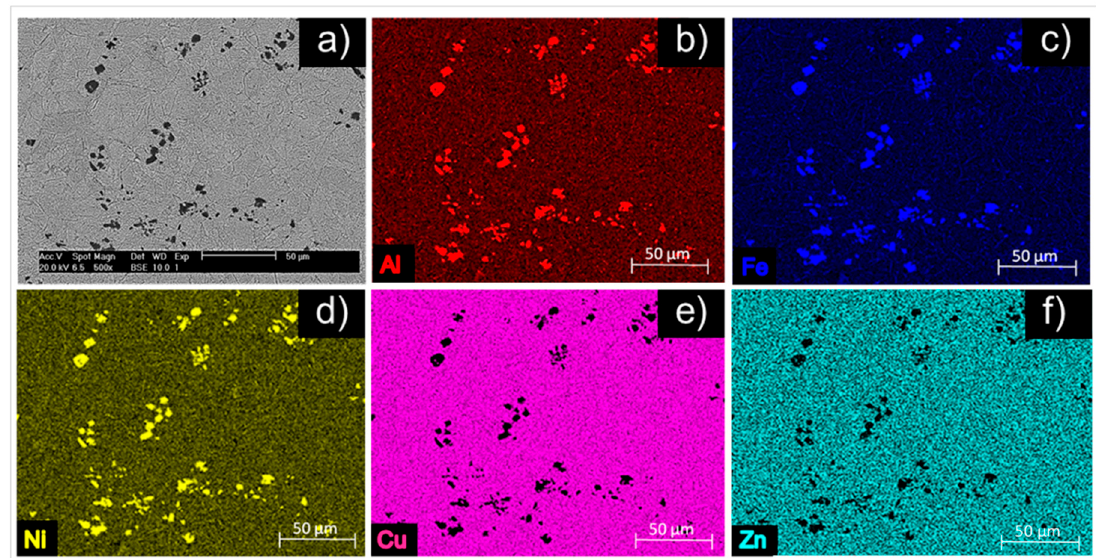
Figure 3. Elemental mapping obtained by scanning electron microscopy (SEM) with energy-dispersive X-ray spectrometry (EDXS) in quenched samples: ( a ) SEM image, ( b ) Al, ( c ) Fe, ( d ) Ni, ( e ) Cu, and ( f ) Zn.